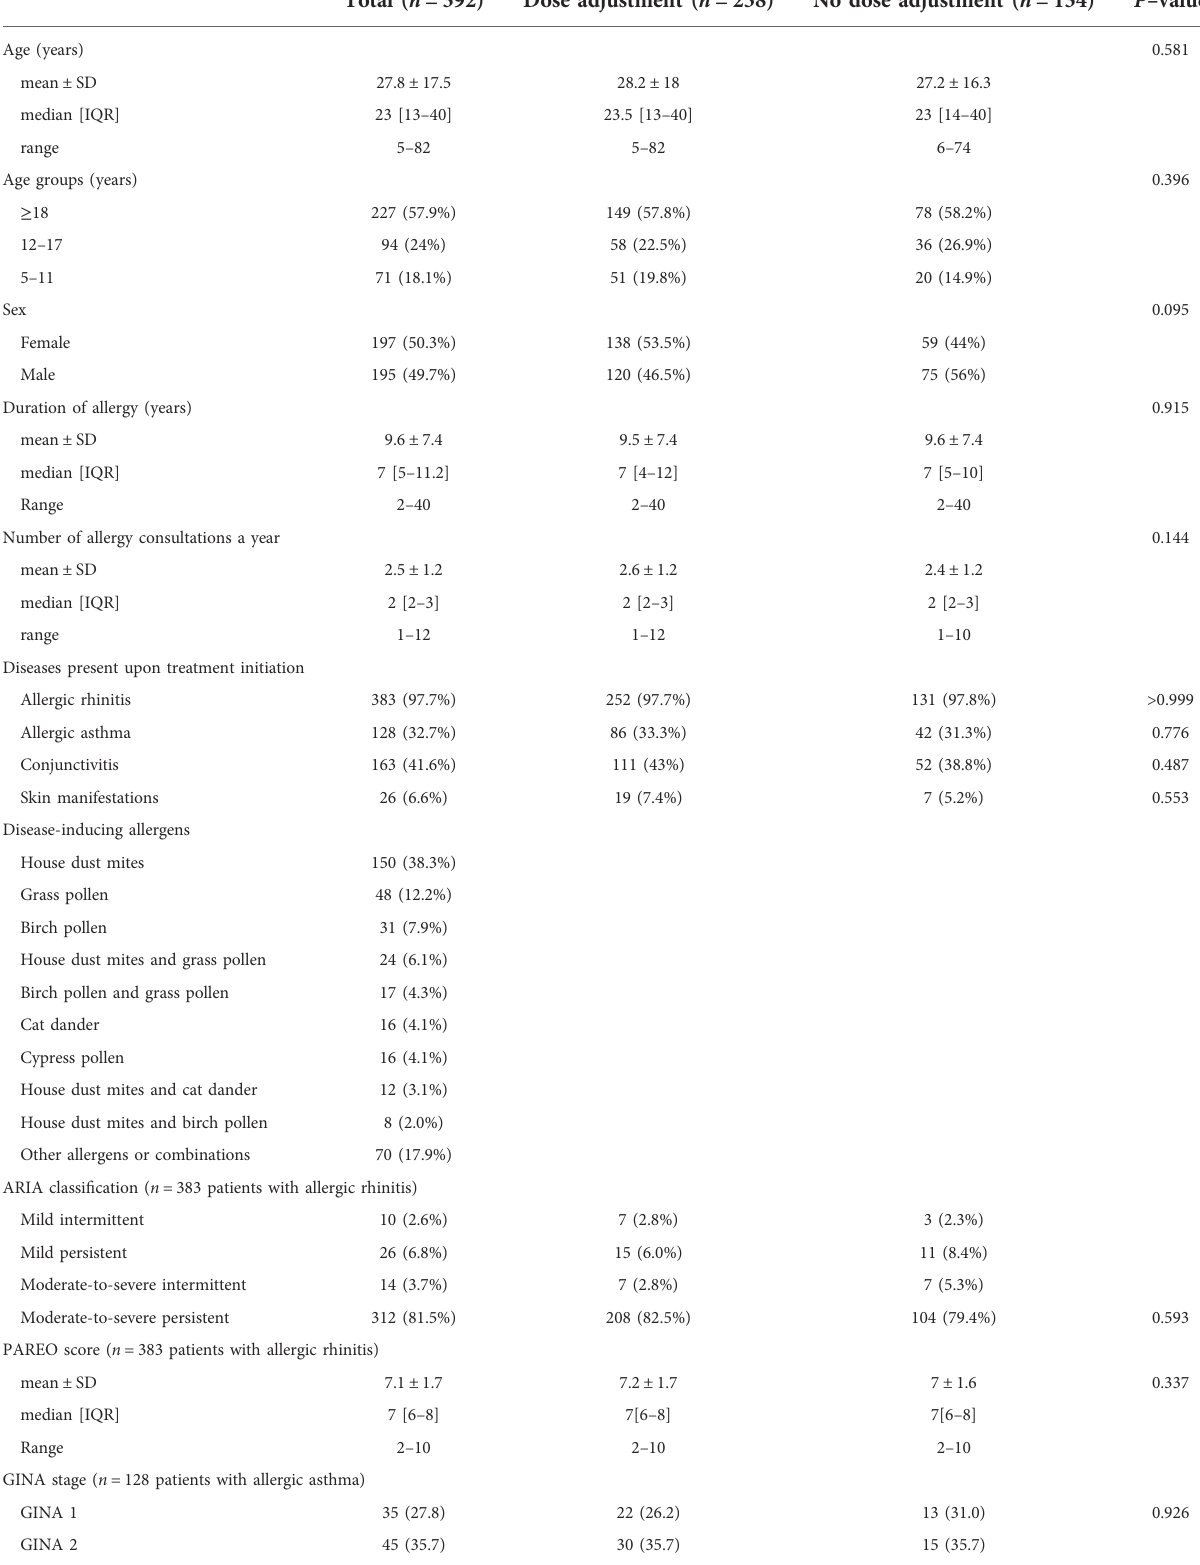
TABLE 3 Characteristics of the patient